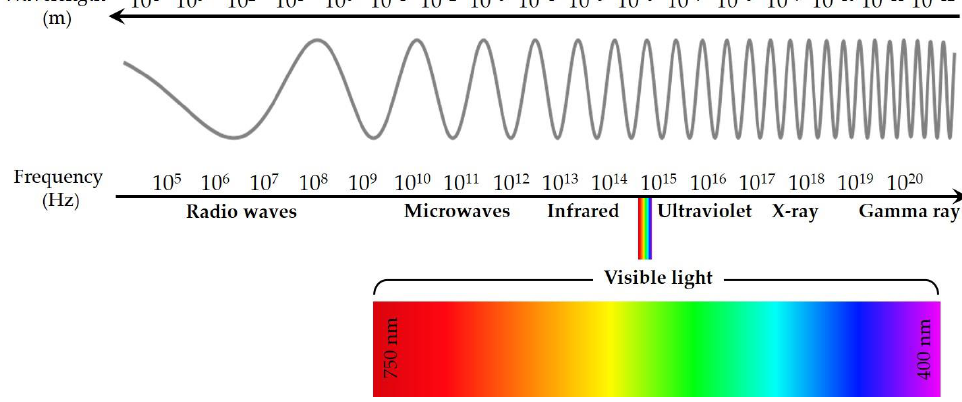
Figure 4. Electromagnetic spectrum.